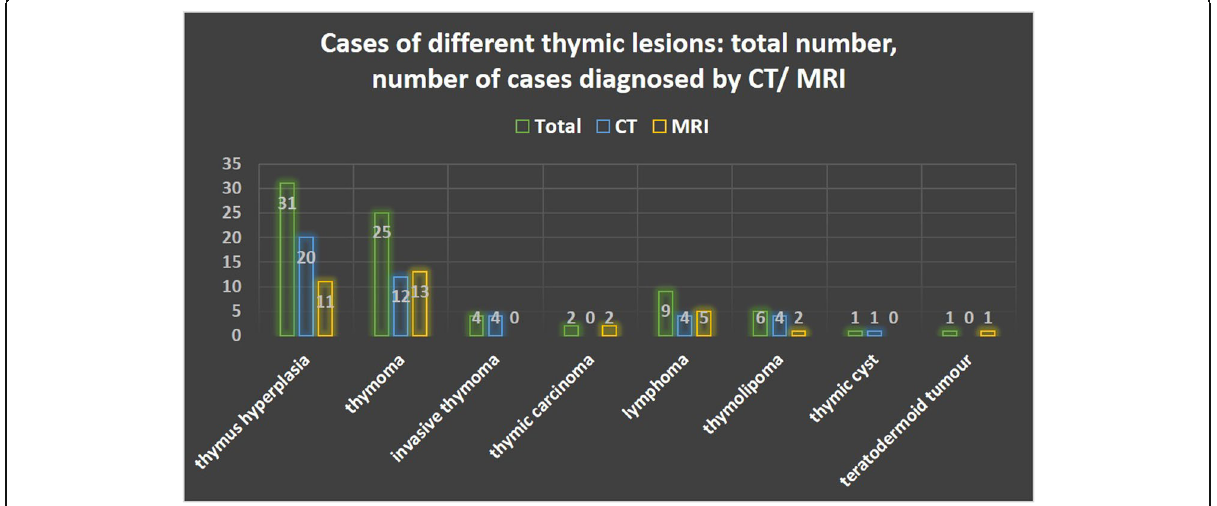
Fig. 6 The histopathological results of cases with different thymic lesions: total number, number of cases diagnosed by